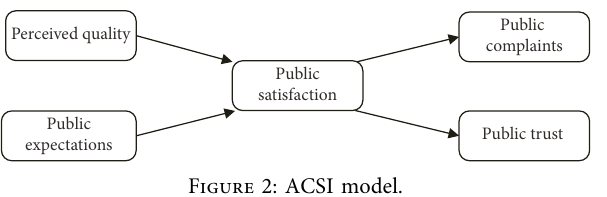
Figure 3: ACSI-based public satisfaction index model for ICH digital display.